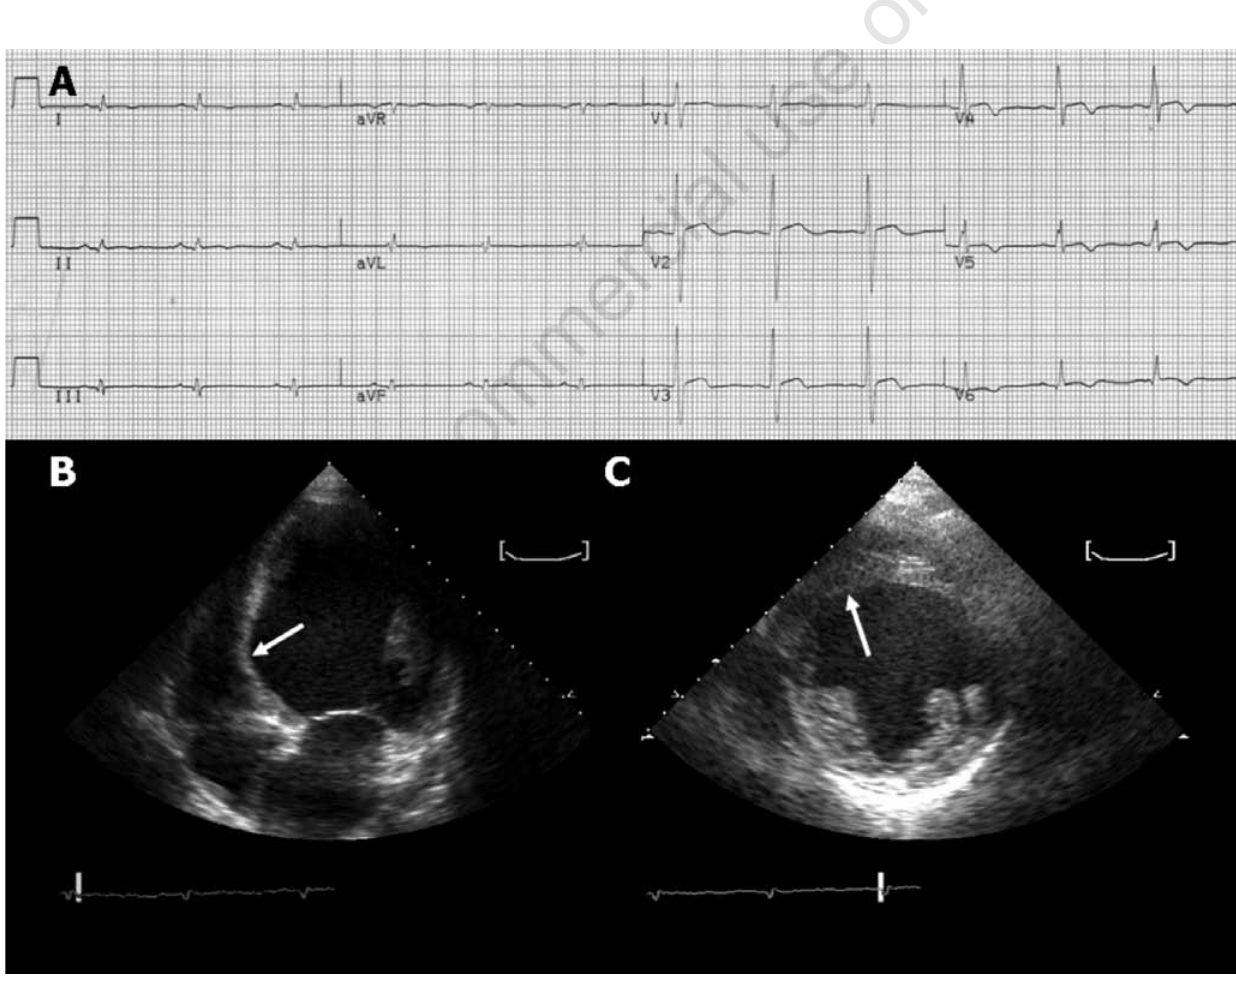
Figure 1. Electrocardiogram (ECG) and echocardiogram of the mother. A) ECG showing sinus rhythm and negative T waves in the lat- eral leads. B) Apical 4-chambers view showing left ventricular (LV) hypertrophy and LV enlargement. C) Parasternal short axis view at level of papillary muscles showing LV hypertrophy and enlargement. Of note, a relative and localized wall thinning at the basal segment of the interventricular septum was present (white